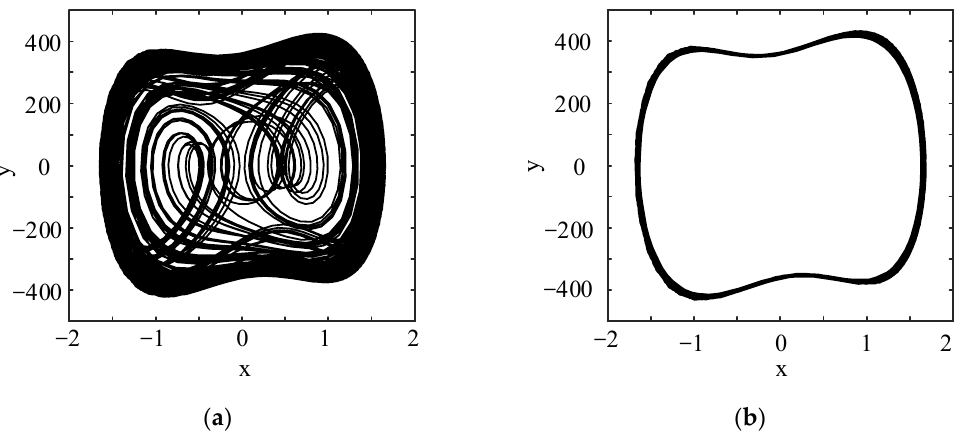
Figure 6. Phase trajectories of the Duffing Oscillator: ( a ) Chaotic state; ( b ) Periodic state. The unknown frequency value of weak periodic signals embedded in the input